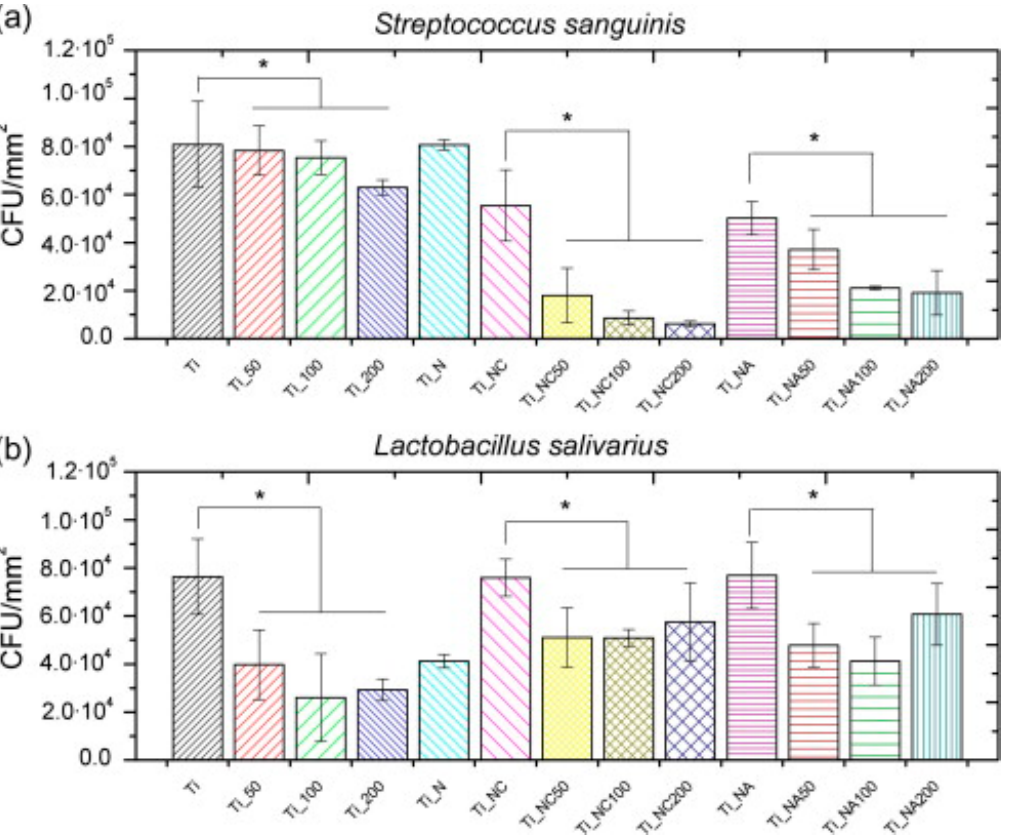
Figure 20. Bacterial adhesion of S. sanguinis ( a ) and L. salivarius ( b ) to titanium samples after 2 h of incubation at 37 °C. Statistically significant differences vs. control samples are indicated with an * ( p < 0.05). Reproduced from [85]. Copyright © 2014 Acta Materialia Inc. Published by Elsevier Ltd. All rights reserved.